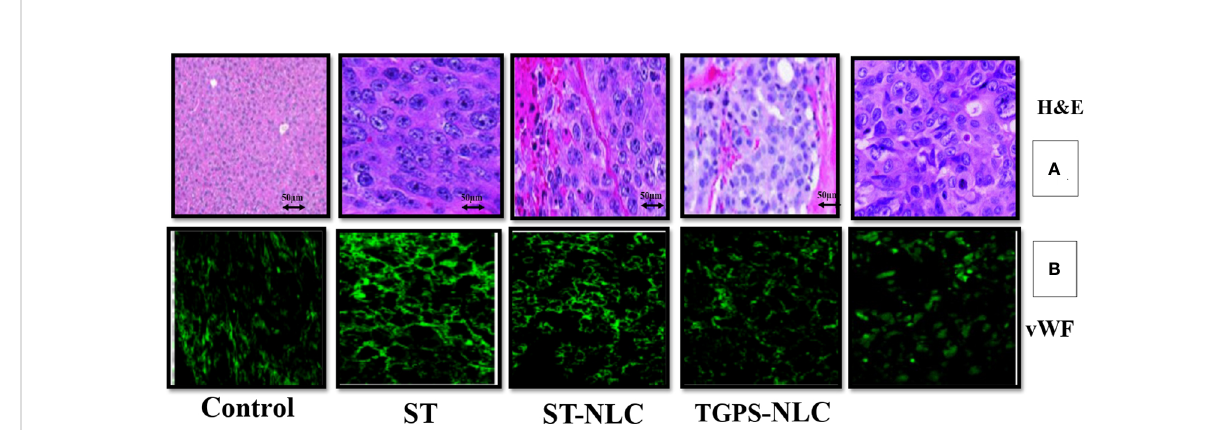
FIGURE 9 Expression pro fi les of neovascularization (vWF) in mice tumors (A) , Representative pictures of H&E-stained sections from CT-26 xenograft tumors in mice. The expression of neovascularization (vWF expression) was visualized by immunohistochemical study using their speci fi c antibodies. vWF were stained with FITC-conjugated IgG (green) (B) . All fi gures are the representation of three mice tumor sections from each experimental